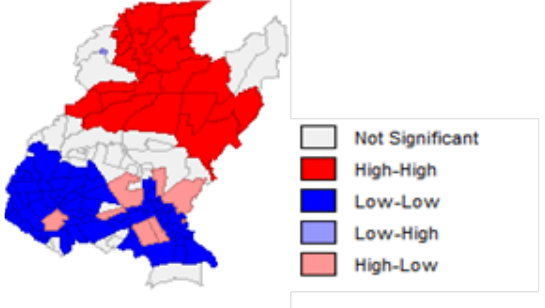
Figure 5. Spatial clusters based on LISA Moran’s I of total cases in